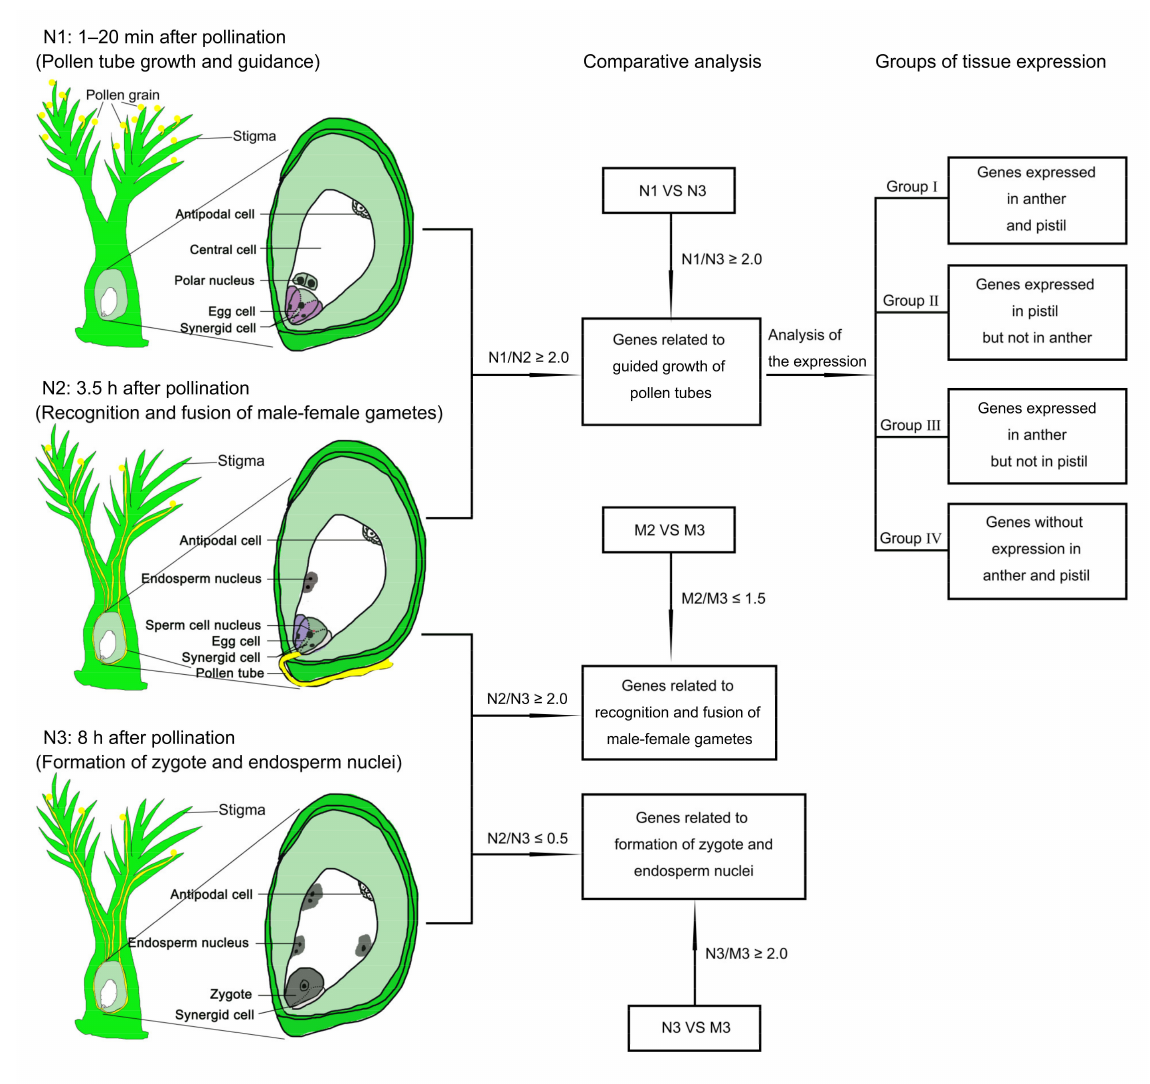
Figure 3. Strategy to identify genes related to rice pollen tube guidance and double fertilization. N1, WT pistil at 1–20 min after pollination; N2, WT pistil at 3.5 HAP; N3, WT pistil at 8 HAP; M1, the mutant pistil at 1–20 min after pollination; M2, the mutant pistil at 3.5 HAP; M3, the mutant pistil at 8